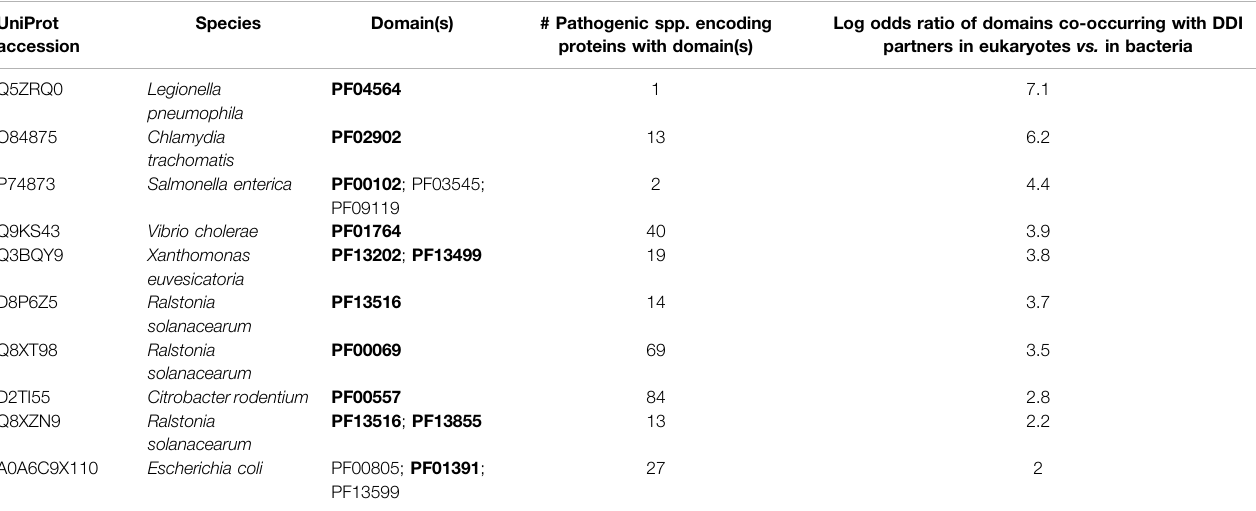
Domains with DDI partners in both eukaryotes and bacteria are marked in